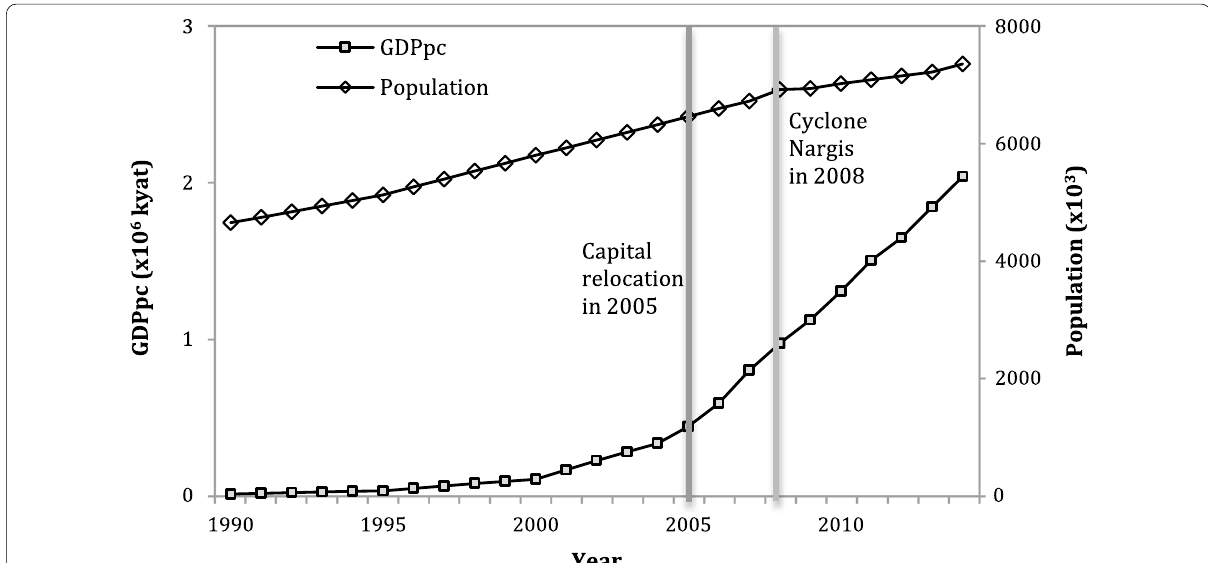
Fig. 4 Changes in population and GDP per capita (GDPpc) in Yangon from 1990 to 2014. Note: Two external events and the growth of population and GDPpc of Yangon, capital relocation in 2005 and Cyclone Nargis in 2008. These two events seem do not have obvious impacts on city’s population or economic development level